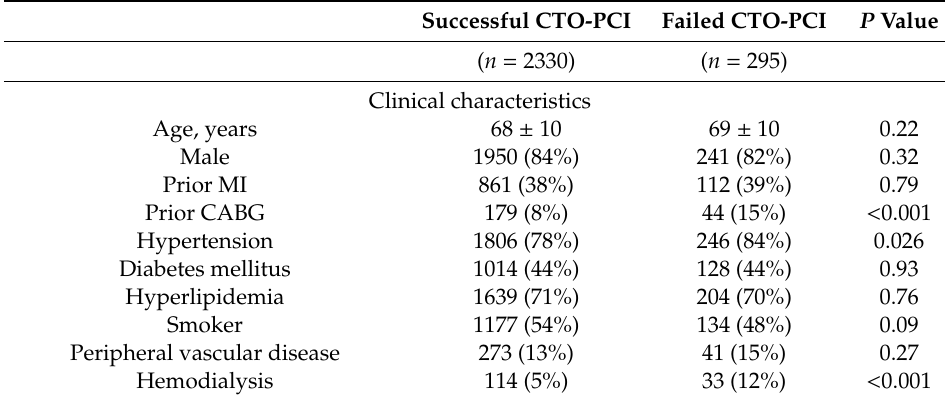
Table 1. Patient